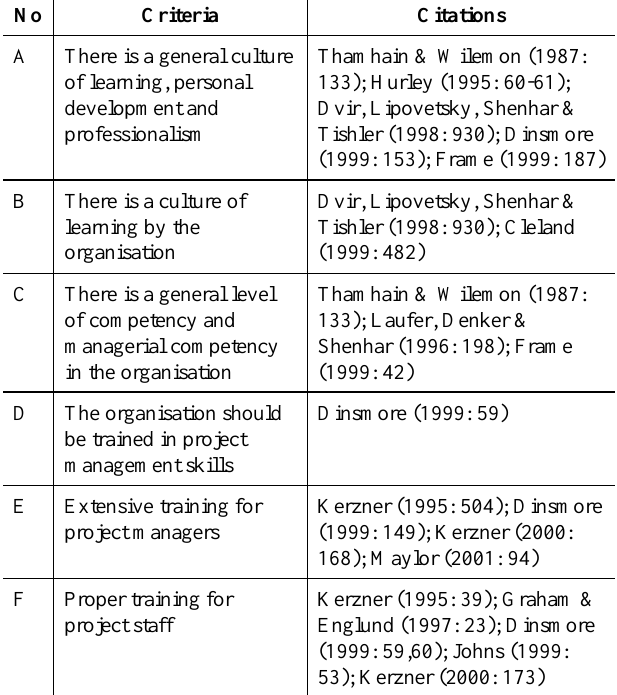
Table 10: The need for training and competency